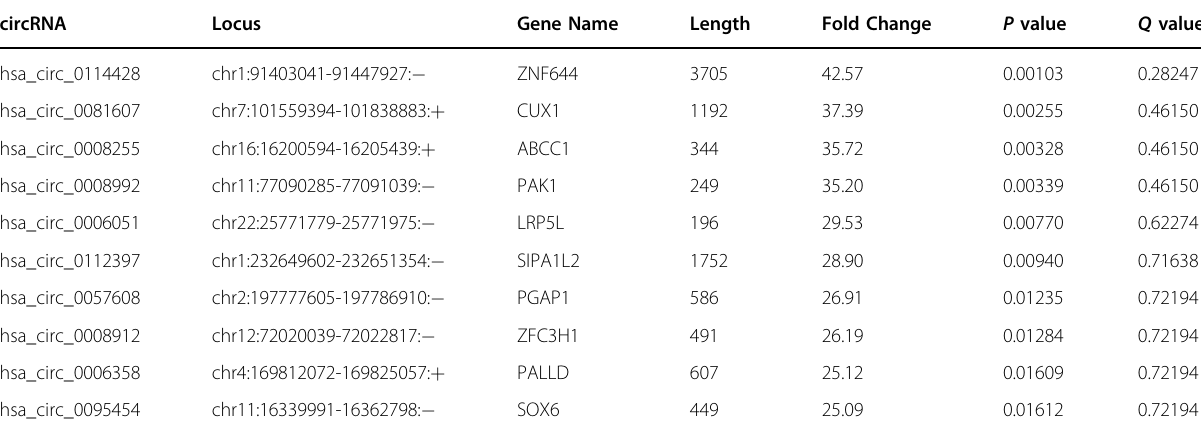
Table 1 Top ten upregulated circRNAs in HPSCC tissues.